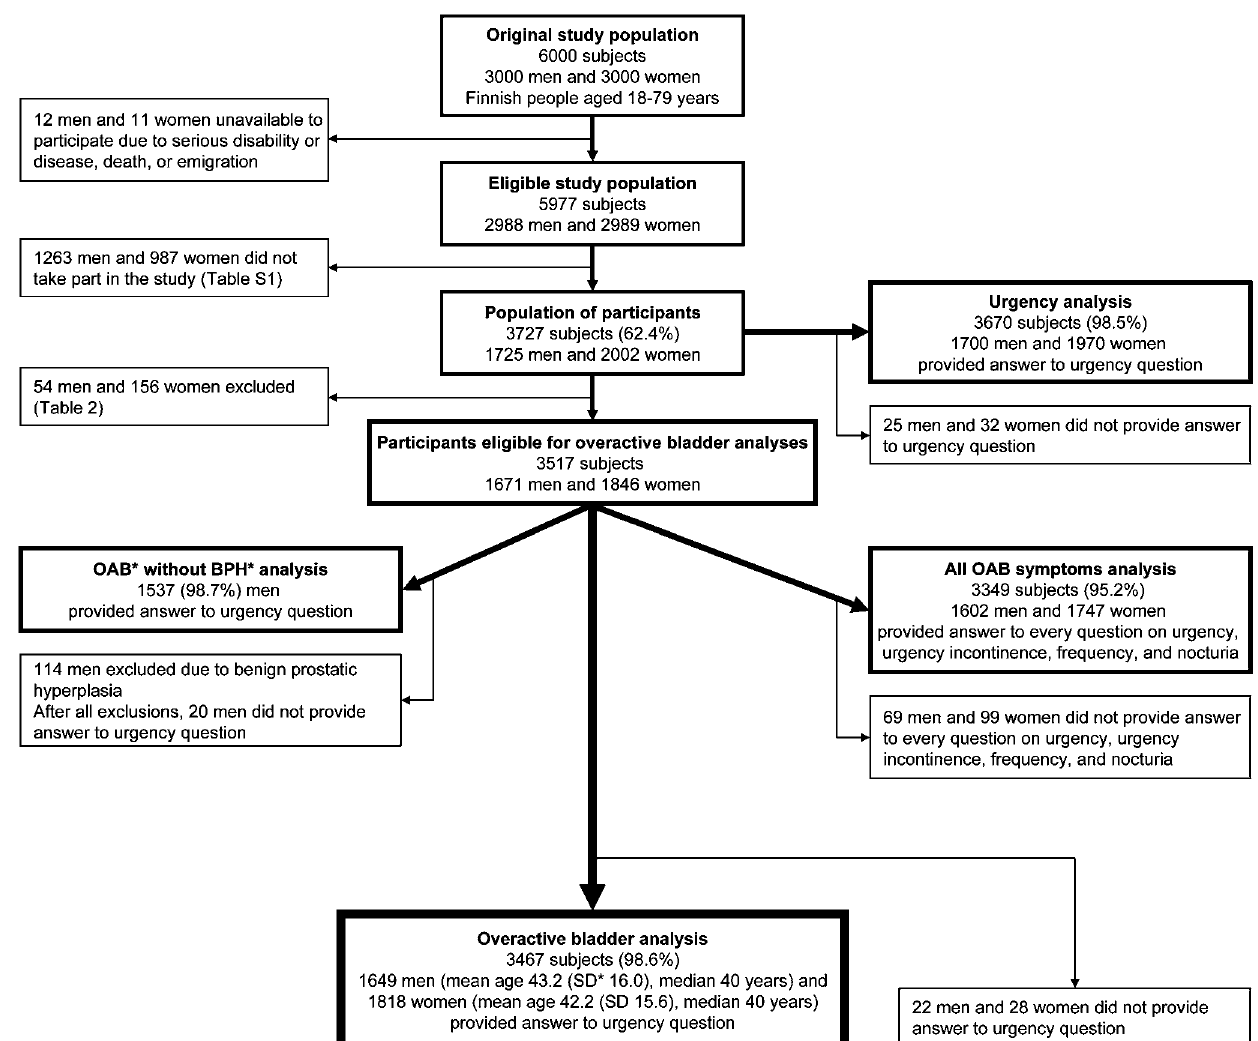
Figure 1. Flow chart of the study in Finland, 2003–2004. * OAB, overactive bladder; BPH, benign prostatic hyperplasia; SD, standard deviation.